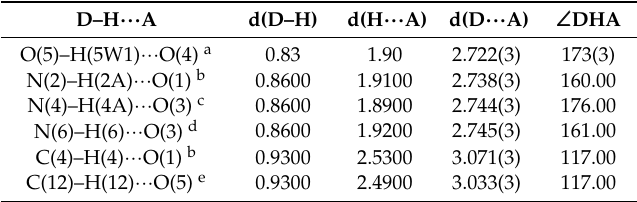
Table 2. Hydrogen Bond Lengths (Å) and Bond Angles ( ◦ ) for 1 .